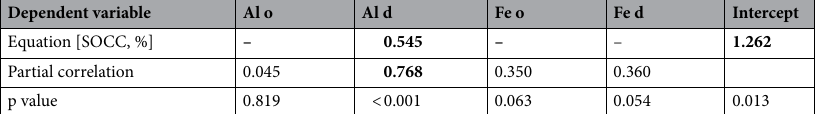
Table 4. Stepwise backward selection multiple linear ridge regression of soil organic carbon concentration (SOCC) on dithionite- and oxalate-extracted secondary Fe and Al: VIF max = 3.94; adj. R 2 = 0.575, p < 0.001. Fe d, Fe o, Al o, Al d dithionite and oxalate extracted Fe and Al, respectively, VIF max maximum value of the variance inflation factor. Numerical values printed in bold are statistically significant (p <